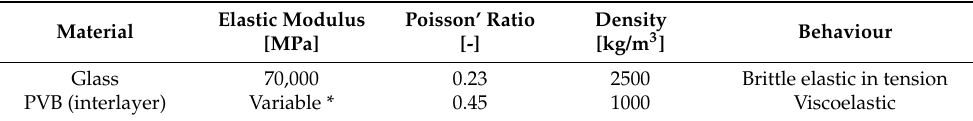
Table 1. Summary of typical mechanical properties for constituent LG materials. * = depending on time loading, temperature, humidity, etc.